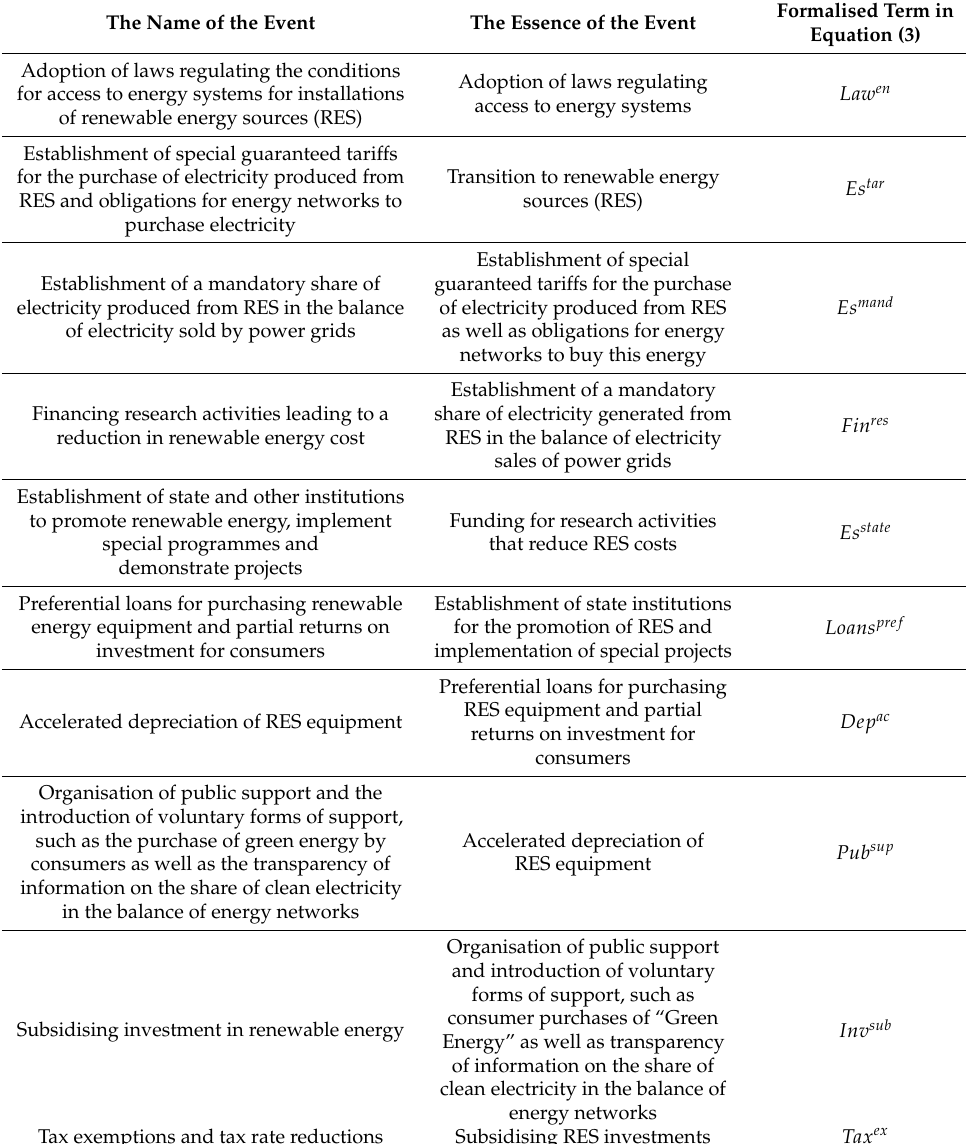
Table 5. Correspondence of mechanisms to support renewable energy and their formalised